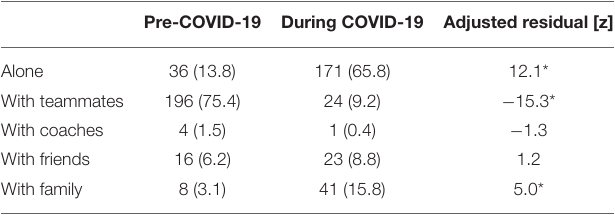
TABLE 3 | Proportions of most common running socialization pre- and during COVID-19 social distancing restrictions reported as n (%). Pre-COVID-19 During COVID-19 Adjusted residual [z] Alone